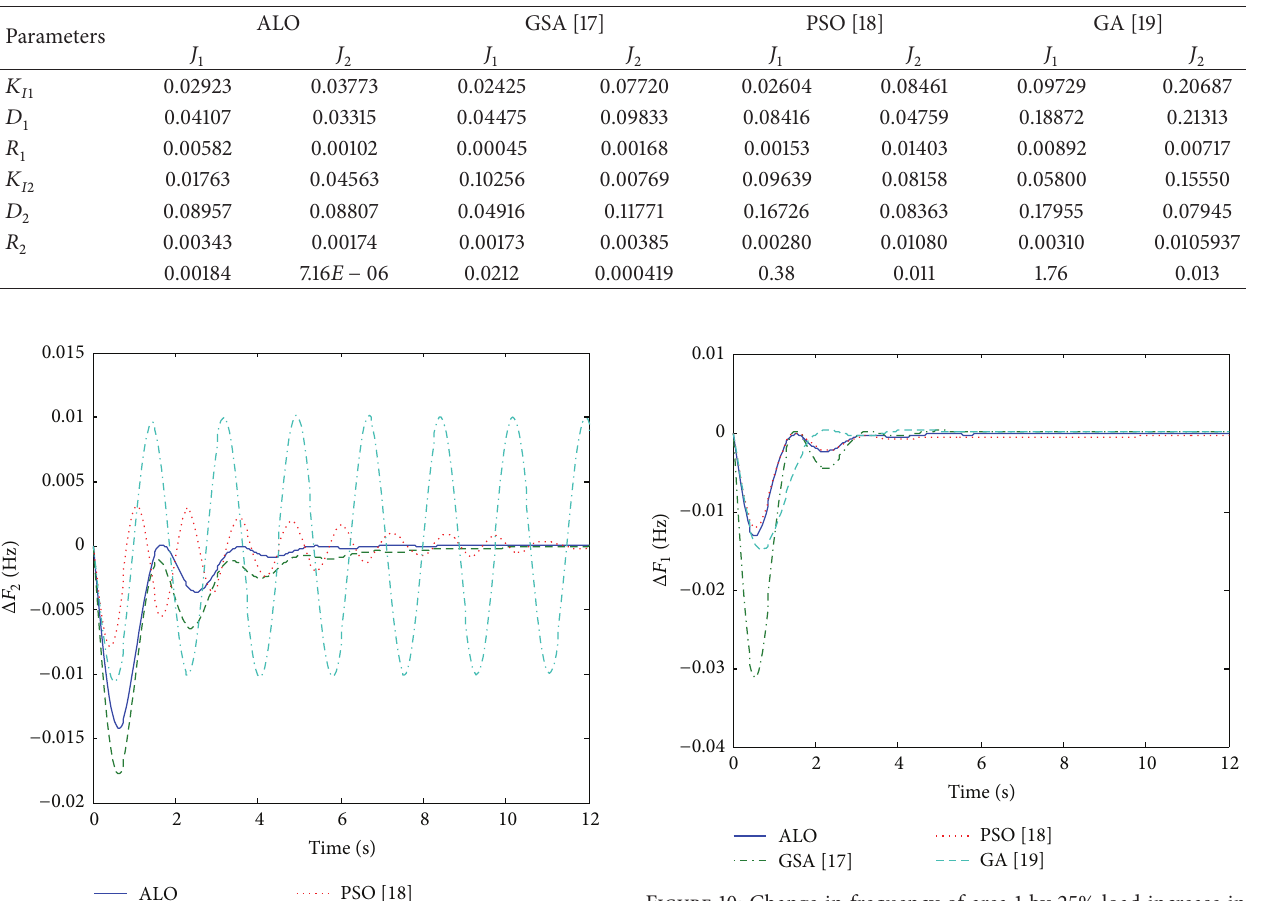
Table 4: Standard deviation of optimized parameters of the regulator.